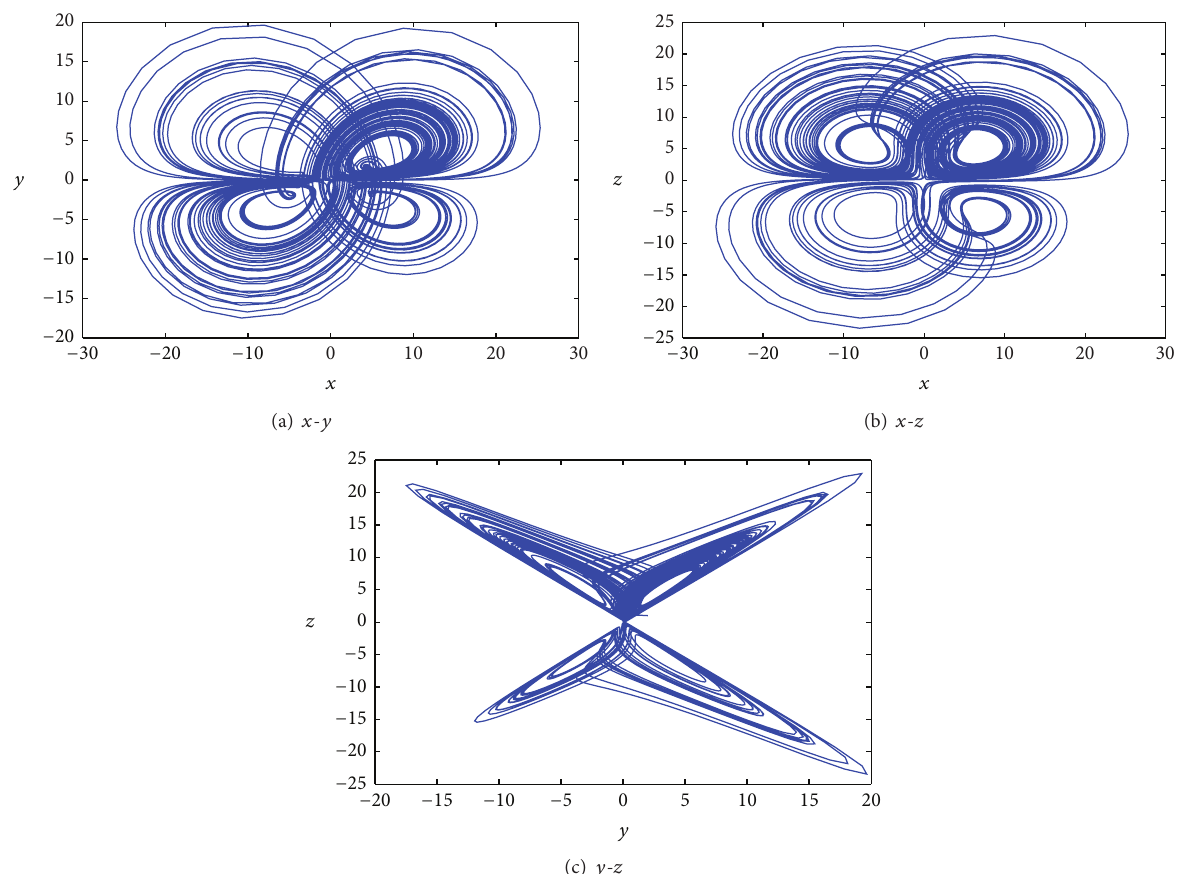
Figure 2: Phase trajectories of wing doubled fractional-order chaotic system (8).